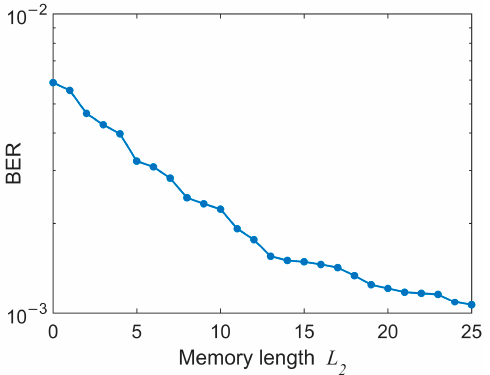
Figure 8. BER versus the memory length L 2 of VNLE with L 1 = 100 at − 8 dBm ROP.